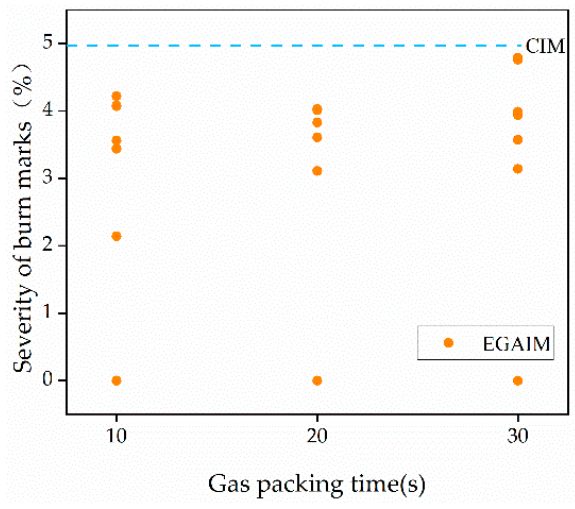
Figure 7. Influence of gas packing time on burn marks.